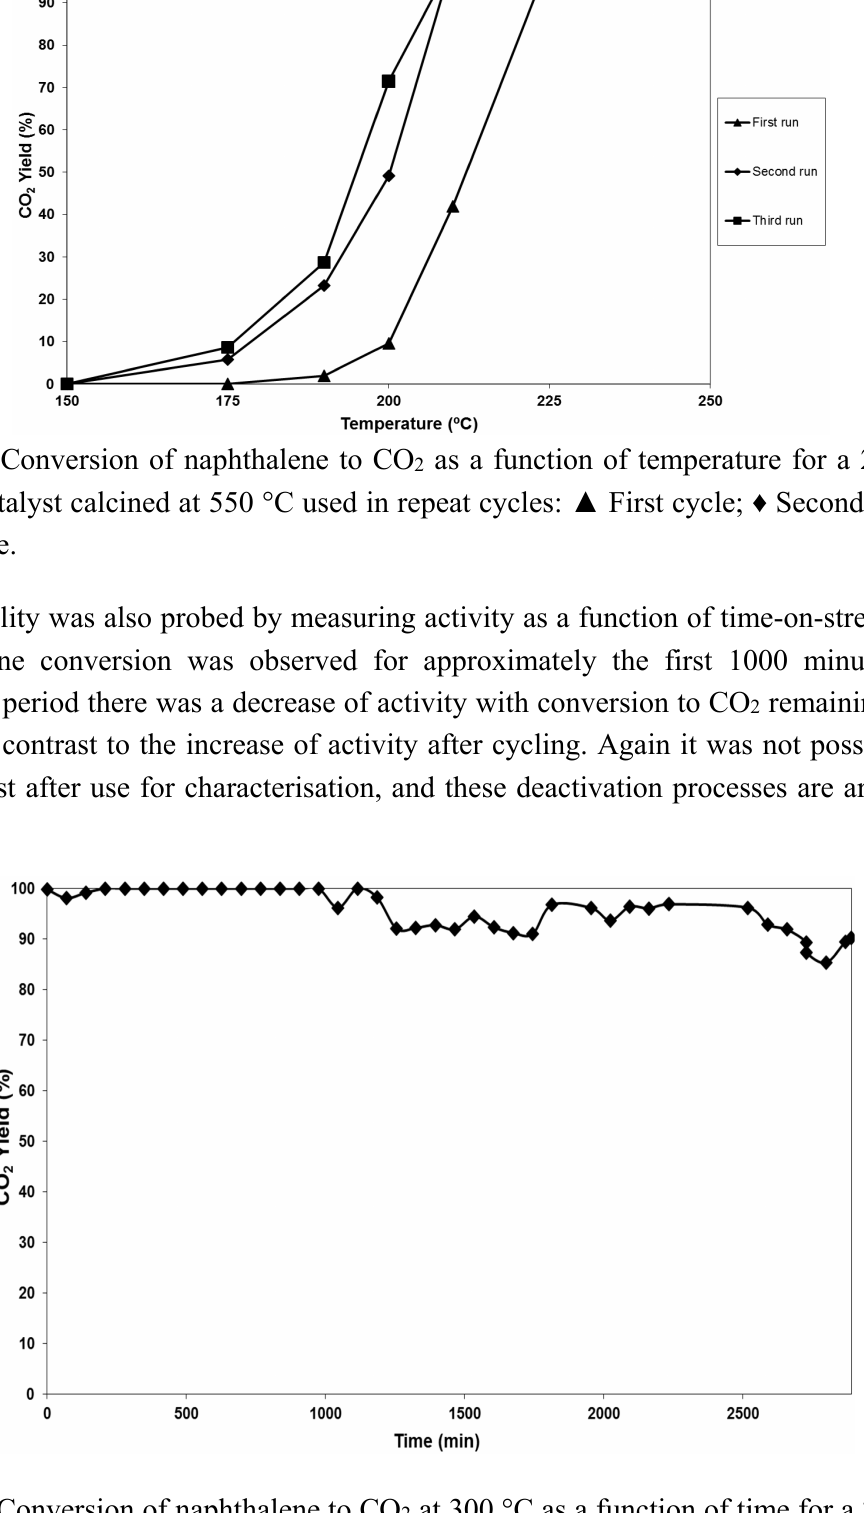
Figure 5. Conversion of naphthalene to CO 2 at 300 °C as a function of time for a 2.5 wt.% Pt/SiO 2 catalyst calcined at 550